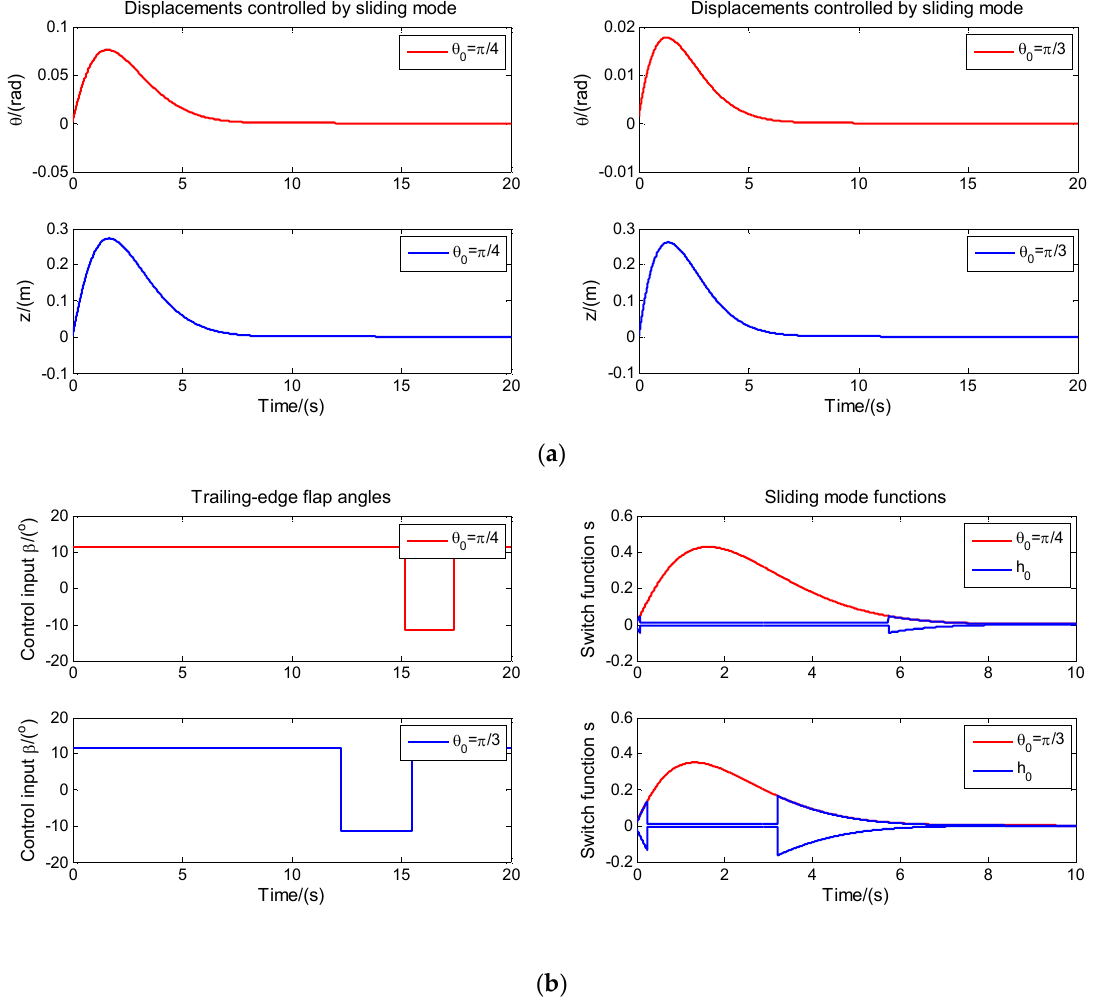
Figure 4. The controlled displacements and control signals: ( a ) The controlled displacements under conditions of ply angles with θ 0 = π /4, π /3, respectively; ( b ) The control inputs (trailing-edge flap angles) and sliding mode functions.